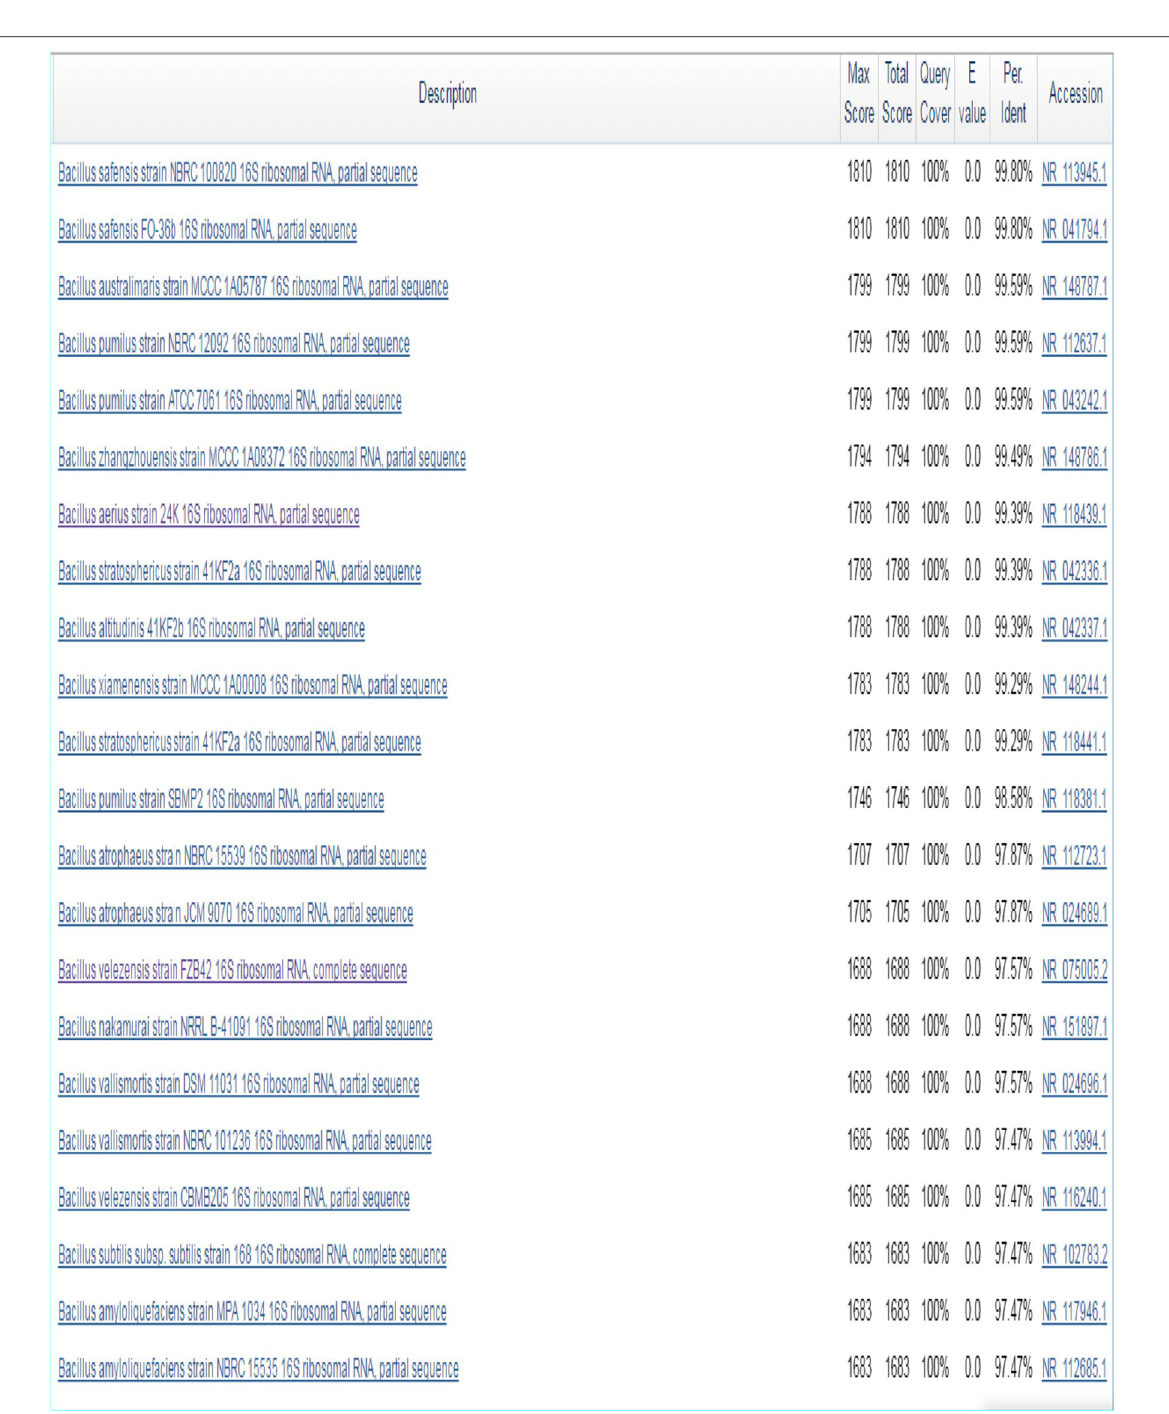
4 times. Inside the cage, a piece of cotton wool previ-